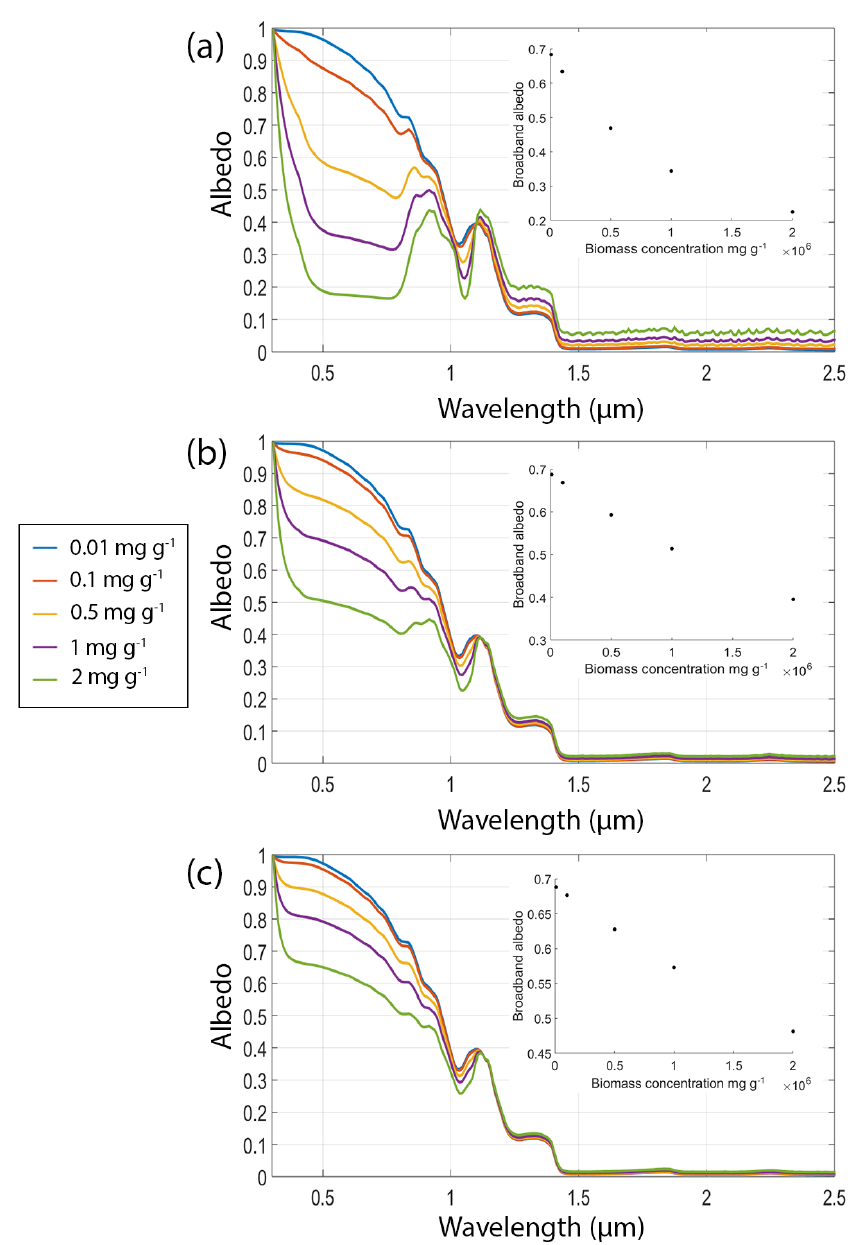
Figure 3. Simulations of 1500µm radius ice grains with no interstitial water or inorganic impurities and biomass concentrations of 0.01, 0.1, 0.5, 1 and 2mg alg /g snow confined to a thin (3mm) surface layer. The mass fraction (% dry weight) of pigments in the cells was 1.5% for chlorophyll a and 5% for each of primary and secondary carotenoids. In (a) the cell radius was 5µm, in (b) the cell radius was 15µm and in (c) the cell radius was 25µm. In all plots the solar zenith was 60 ◦ . Legend applies to all three subplots. Insets show broadband albedo against biomass concentration for each cell